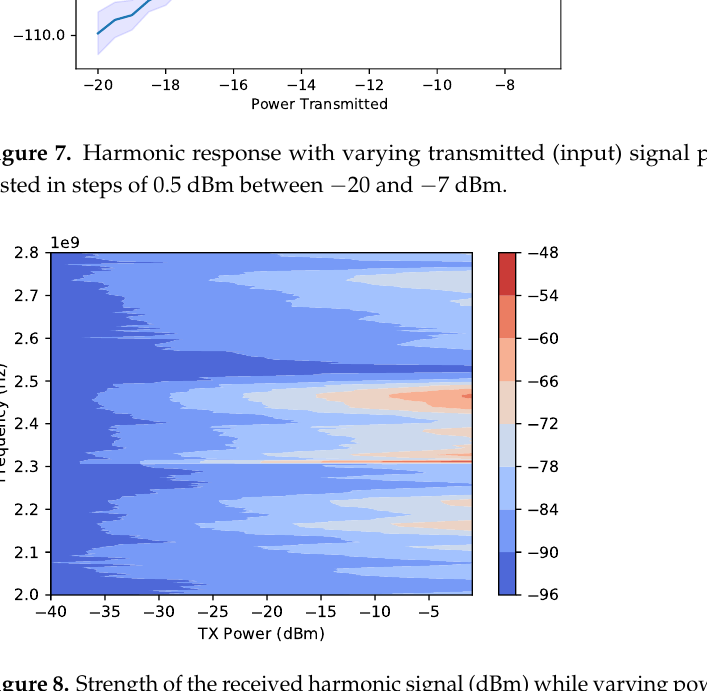
Figure 8. Strength of the received harmonic signal (dBm) while varying power and frequency